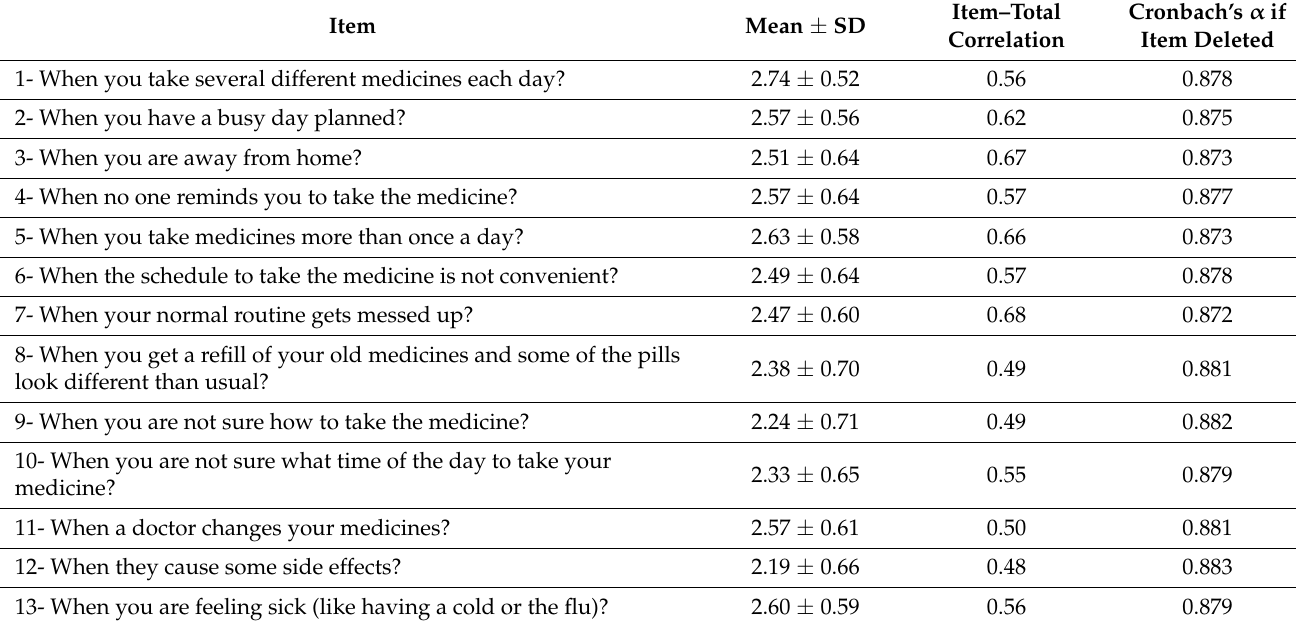
Table 2. Item analysis of the 13-item